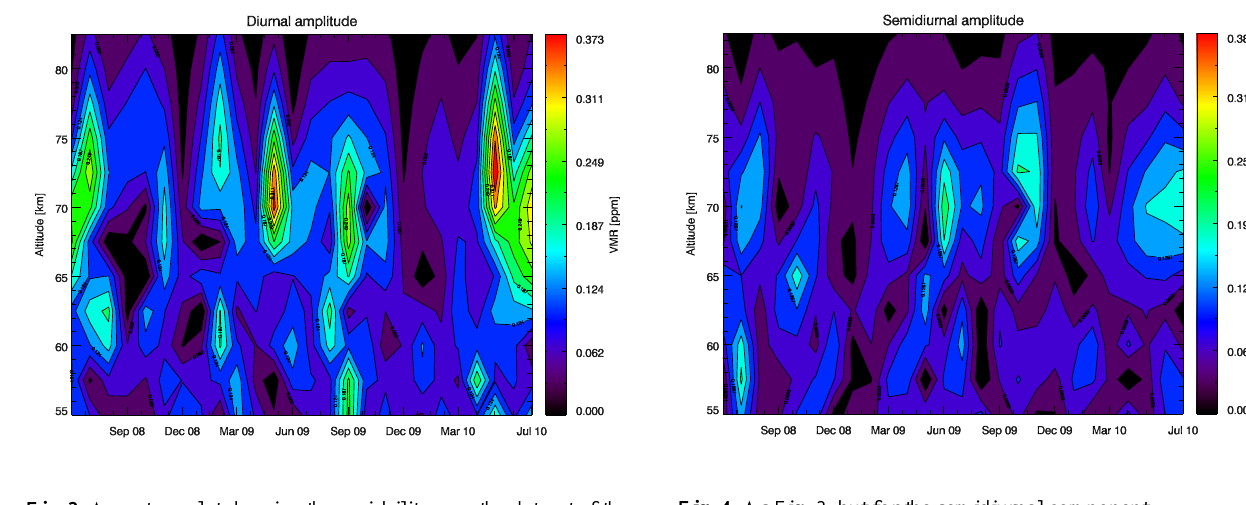
Fig. 3. A contour plot showing the variability over the dataset of the diurnal component of the fitted tide. Note the strong increase in the amplitude at each equinox.